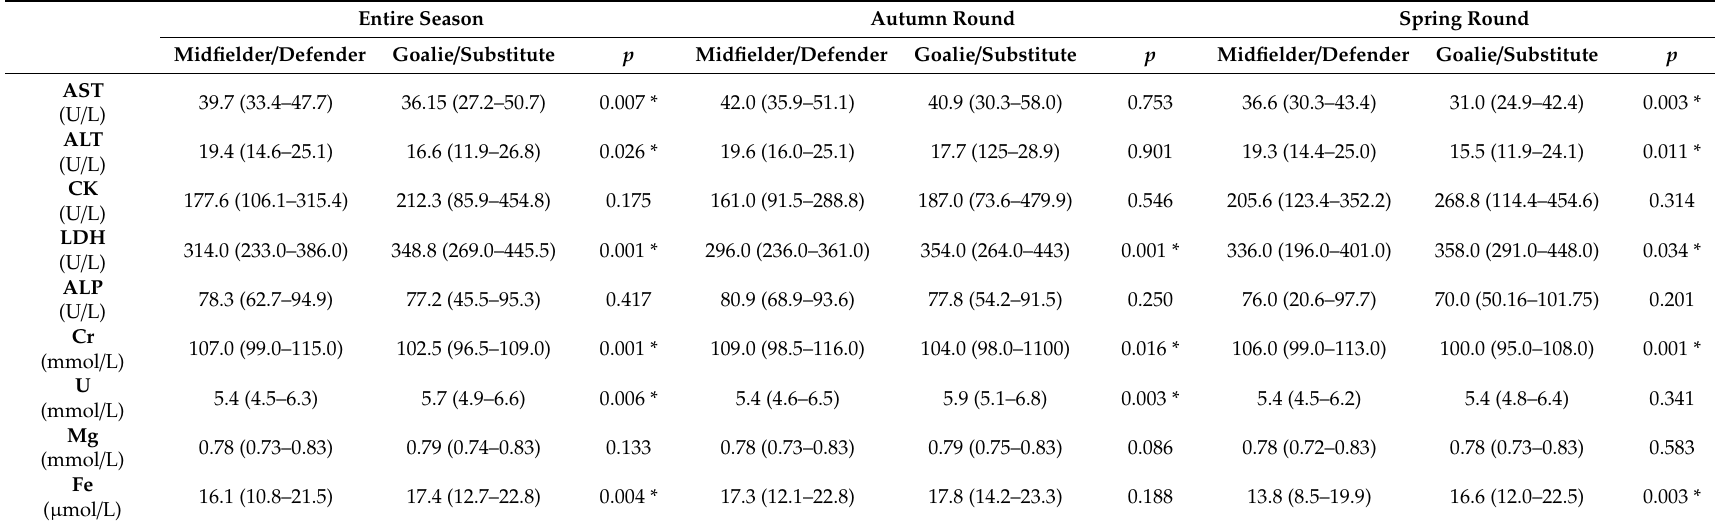
Table 3. Comparison of the midfielder / defender and goalie / substitute subgroups in terms of selected plasma biomarker values during the soccer match season. Entire Season Autumn Round Spring Round Midfielder / Defender Goalie / Substitute p Midfielder / Defender Goalie / Substitute p Midfielder / Defender Goalie / Substitute